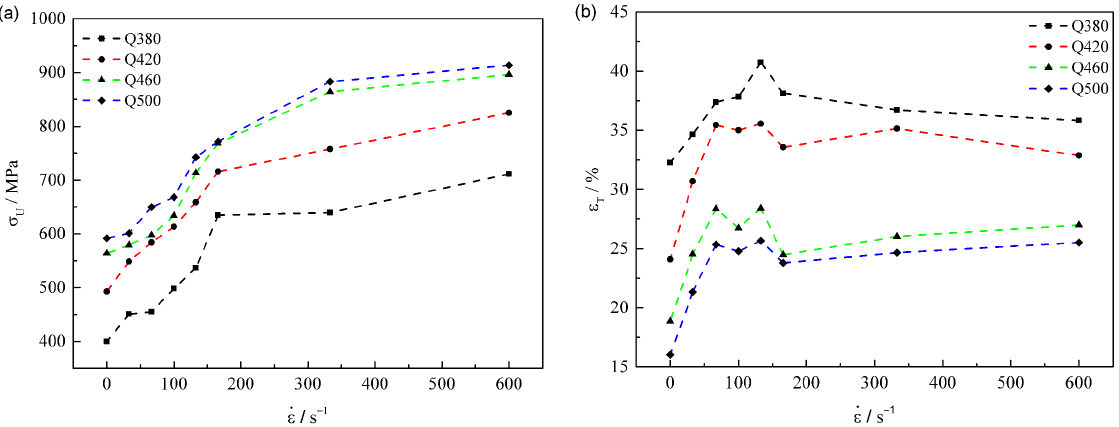
Figure 6. Dynamic response of ( a ) the upper yield stress ( σ U ) and ( b ) the total elongation dependence of strain rate for different steels.